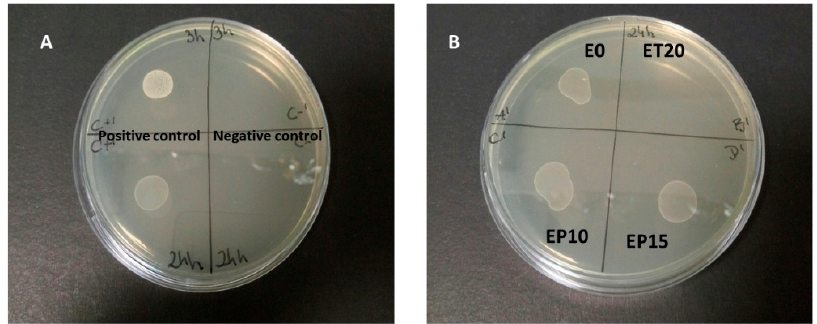
Figure 10. Antibacterial activity against S. epidermidis after 24 h incubation . ( A ) Positive control (liquid medium + S. epidermidis) and negative control (liquid medium without bacteria); ( B ) E0, ET20, EP10 and EP15 membranes.